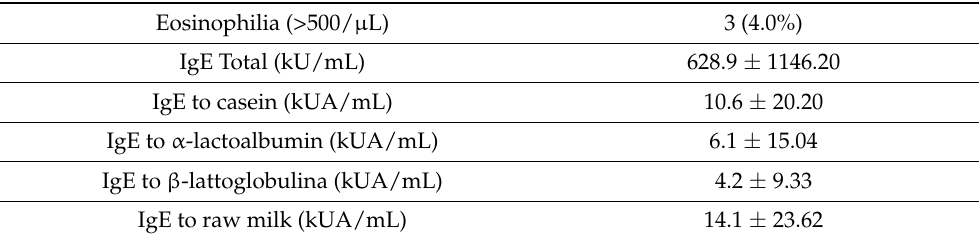
Table 1. Laboratory data before oral food challenge.